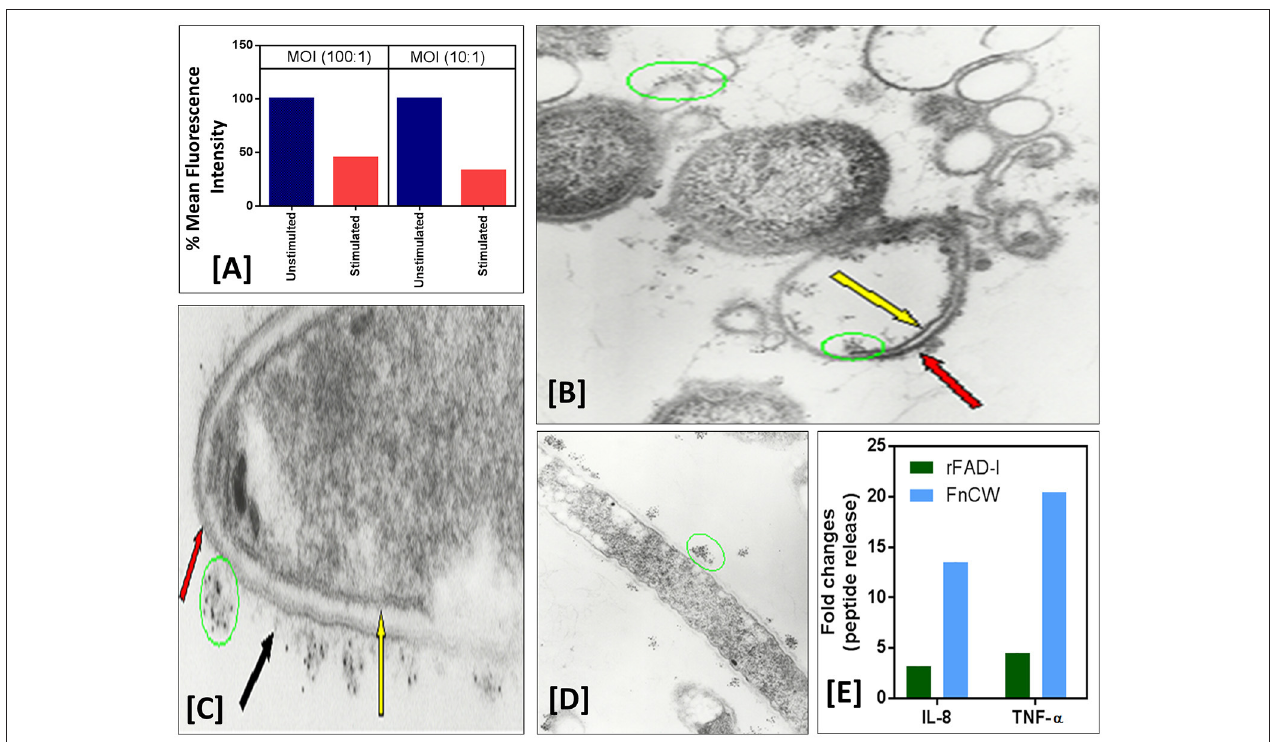
FIGURE 2 | (A) F. nucleatum stimulation of normal human oral epithelial cells (HOECs) confers protection against P. gingivalis invasion. Semi-confluent (80%) monolayers of HOECs were either unchallenged or challenged with F. nucleatum cell wall fraction (FnCW) (10 µ g/ml) for approximately 18 hrs. P. gingivalis was then added at a multiplicity of infection (MOI) of 10:1 or 100:1, 90min, 37 ◦ C, 5% CO 2 . After 1h incubation with gentamycin and metronidazole, cells were harvested and subjected to flow cytometric analysis. Results revealed a 54.3 and 67.2% reduction in P. gingivalis invasion for the 100:1 and 10:1 MOI’s respectively, when compared to non F. nucleatum challenged HOECs. (B–D) Immunogold transmission electron microscopy (TEM) of F. nucleatum and P. gingivalis incubated with rhBD-2. Overnight cultures of F. nucleatum (ATCC strain 25586) and P. gingivalis (ATCC strain 33277) (1.6 × 10 9 cells/ml) were incubated with recombinant hBD-2 (rhBD-2) (10 µ g/ml), 3h, 37 ◦ C anaerobically, and embedded in 1.5% low gel temperature agarose (Bio-Rad), respectively. Samples were fixed, 10min at room temperature with 1% formaldehyde and 0.1% glutaraldehyde in 1x HEPES-buffered saline (pH 7.4), followed by washing 3X with 1X phosphate buffered saline (PBS) containing 0.05M glycine to block glutaraldehyde groups remaining on the cell surface. Samples were blocked in PBS with 1% BSA (bovine serum albumin; PBS-BSA), followed by incubation with goat anti-hBD-2 antibody (Cell Sciences, Canton, MA) (1:100) in PBS-BSA, 2h, room temperature. After washing, samples were incubated, 2h, in 5nm gold-conjugated rabbit anti-goat IgG (BB International) (1:30) in PBS-BSA. To stabilize the gold particles, the samples were fixed with glutaraldehyde and post-fixed in 1% osmium tetroxide for 1h. Samples were then block-stained in 0.5% of aqueous uranyl acetate, dehydrated in ascending concentrations of ethanol and embedded in Epon 812. Ultrathin sections were then stained with 2% uranyl acetate in 50% methanol and lead citrate, and examined in an electron microscope (Model Zeiss CEM902, Oberkochen, Germany). Black arrow points to F. nucleatum amorphous-like structures emanating from the organism’s outer membrane to which immunogold labeled rhBD-2 (green circles) is sequestered, keeping it from interacting with the bacterium’s outer membrane (red arrows) (C) . Yellow arrow points to intact F. nucleatum cytoplasmic membrane. Extensive P. gingivalis cellular debris of outer (red arrow) and cytoplasmic membrane (yellow arrow) with rhBD-2 sequestered to these structures (green circles) are also shown (D) . (E) Semi-confluent HOECs were treated with 10 µ g/ml of either FnCW or recombinant FAD-I (rFAD-I) for 18h. Levels of IL-8 and TNF- α in the supernatants were measured by ELISA (R&D systems, MN, US). Fold change in IL-8 and TNF- α released by each of the treatment compared to untreated cells were